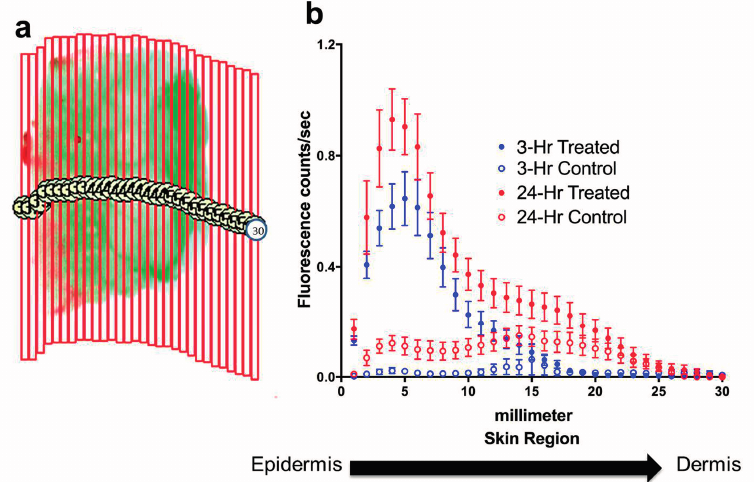
Figure 3. Digital sectioning and quantification of penetration of nanoparticles through skin specimens. ( a ) Illustration of digital sectioning for quantification of near-infrared signal through skin layers. The fluorescence image of each specimen was divided into a uniform set of thirty 0.5 mm-wide, vertical regions spanning the cross-section of the specimen, and the signal was quantified for each region. ( b ) Quantification of signal intensity through skin layers following 3-hour and 24-hour incubations. Quantified near-infrared signals for each group show progression of the signal well into the skin in a characteristic diffusion gradient pattern. The control specimens displayed a consistently lower signal than treated specimens, and 24-hour incubation with nanoparticle cream produced higher signal than 3-hour incubation. Data show mean ± standard error, with n = 12 for 3-hour